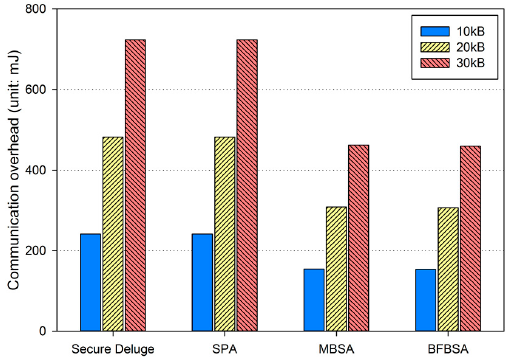
Figure 14. Communication overhead in fair link quality.